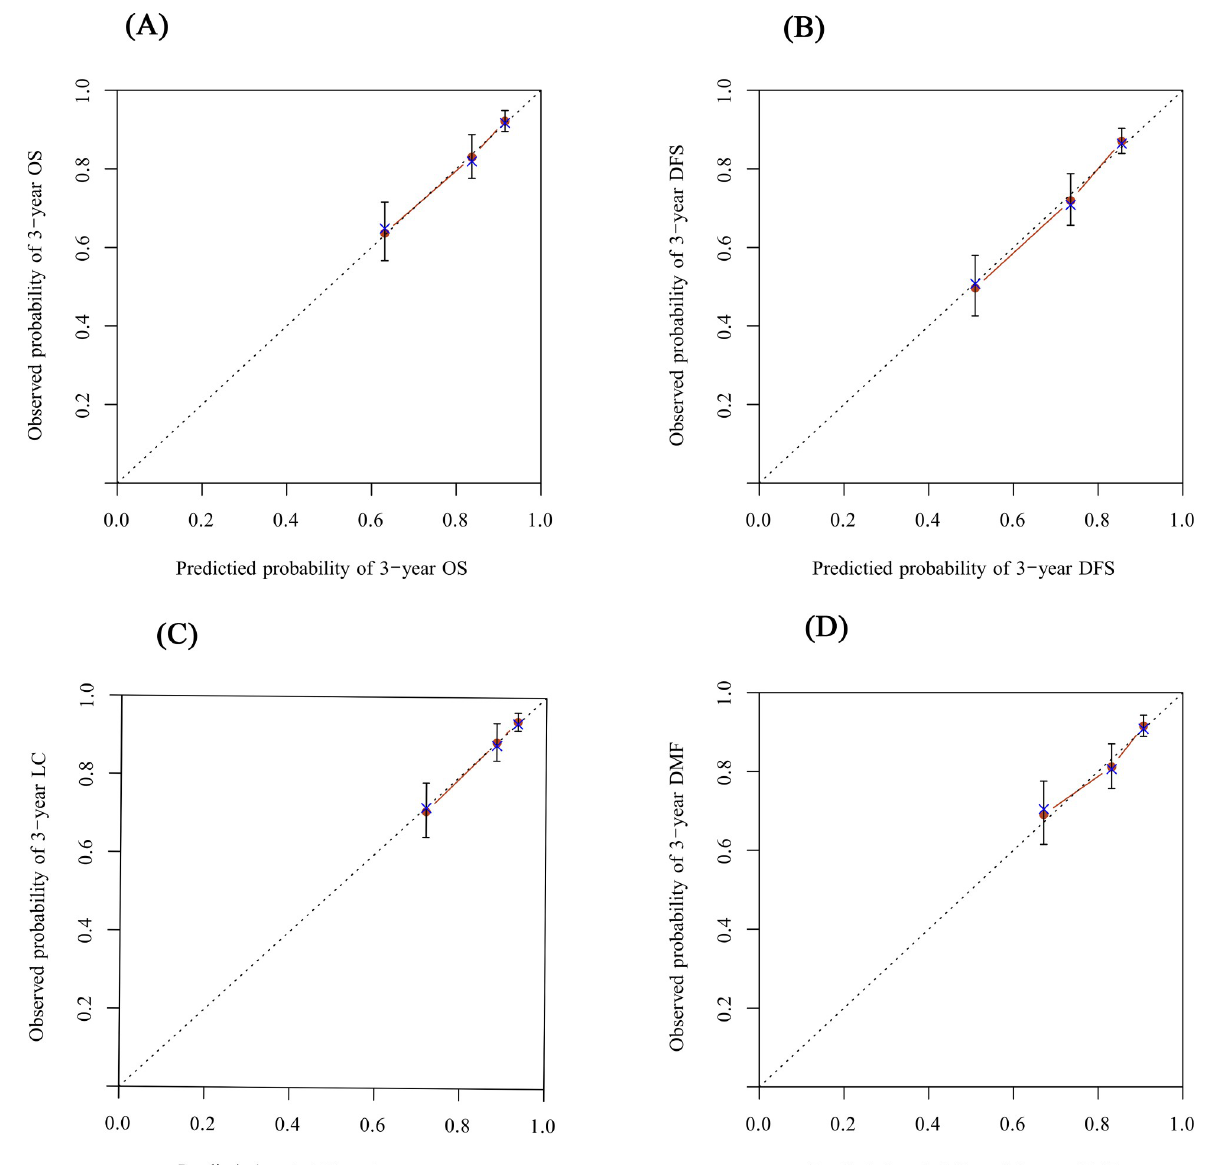
Fig 2. Calibration curve for nomogram of the 3-year overall survival (OS, Fig 2A), disease-free survival (DFS, Fig 2B), local control (LC, Fig 2C) and distant metastasis-free (DMF, Fig 2D) prediction.